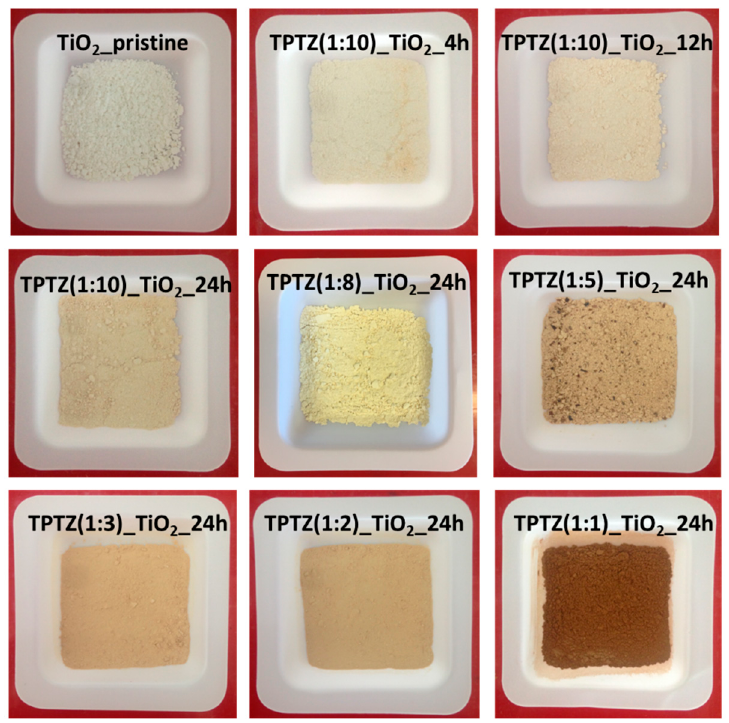
Figure 7. Colors of the samples of pristine TiO 2 and TiO 2 obtained using various molar ratios